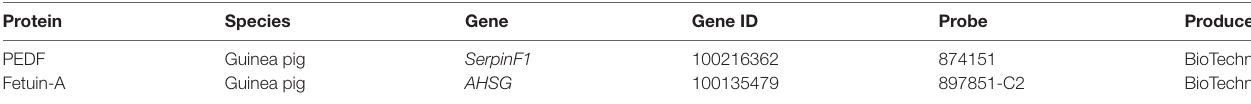
TABLE 2 | RNAscope probes. Protein Species